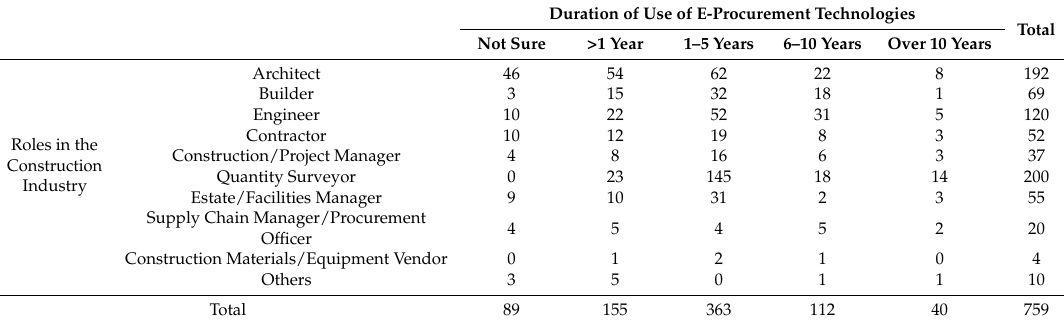
Cross-tabulation of the construction stakeholders and the duration of using e-Procurement